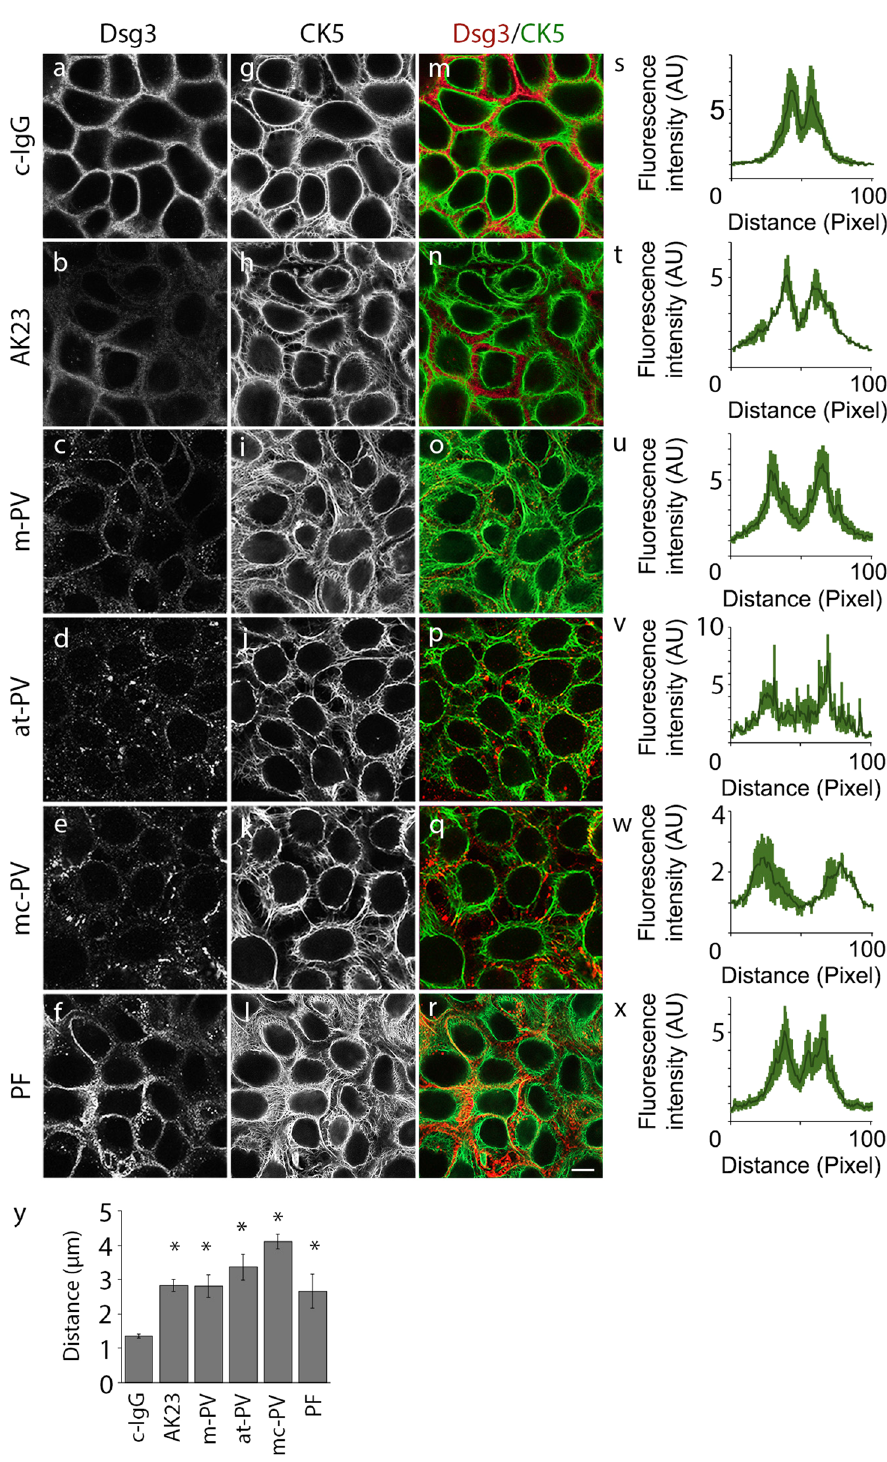
Figure 1. Structural changes in keratinocytes after 24 h of IgG treatment. HaCaT keratinocytes stably expressing CK5-YFP were exposed to different IgG fractions for 24 h. Images shown are representatives of four independent experiments. Dsg3 staining ( a – f ) and CK5 expression ( g – l ) after IgG treatment. ( m – r ) Merged images of Dsg3 staining and CK5-YFP. ( s – x ) CK5 fluorescence intensity of a 100 pixel long line placed centrally over the cell membrane (n = 4). ( y ) Analysis of the distance between fluorescence peaks shown in ( s – x ) in μ m (n = 4, * p ≤ 0.05 vs. c-IgG). Bar represents 10 μ